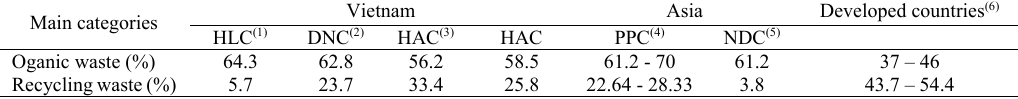
Fig. 5: Solid waste composition of the hotel industry Table 4. Comparison of solid waste composition in Hoi An city and other cities